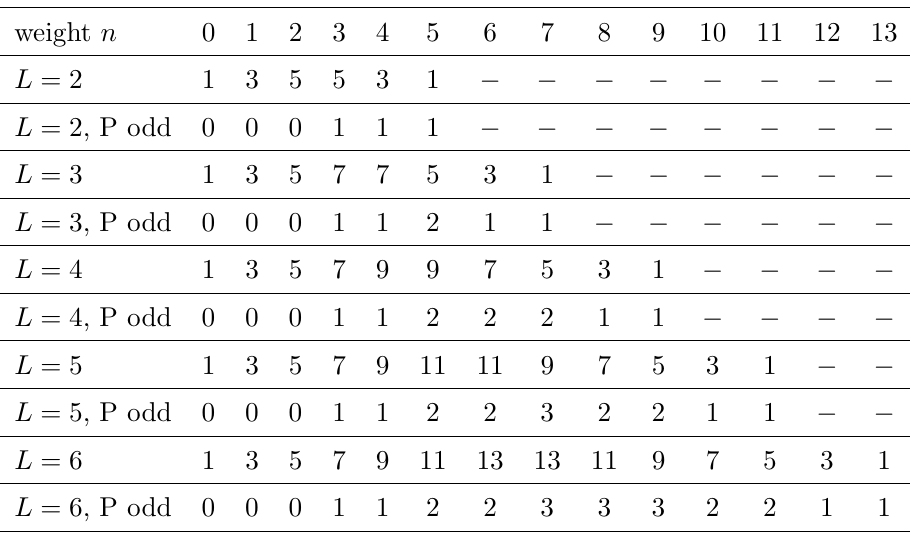
Table 2 . The dimensions of the spaces of f n; 1 ; : : : ; 1 g coproducts of the odd ladder integral O ( L ) , and also that of the parity odd subspace. They are both palindromic